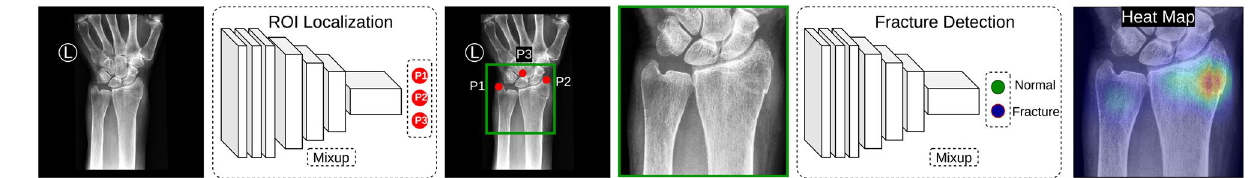
Figure 1. DeepWrist pipeline. From left to right: a wrist radiograph is passed to ROI (region of interest) localization block, which predicts three landmark points (P1, P2 and P3). Subsequently, these landmarks are used to crop an ROI image from the original radiograph. Finally, we utilize a fracture detection block which predicts whether the radiograph is normal or has a fracture. In addition to the prediction, we generate an explanation of the decision using a GradCAM